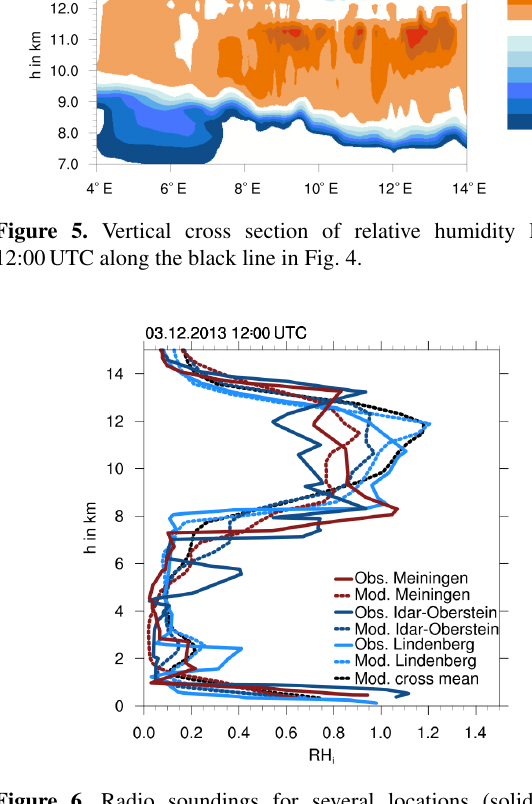
Figure 6. Radio soundings for several locations (solid lines) (UWYO, 2018) and corresponding profiles from aviation simula- tion (dotted lines) of relative humidity RH i . The black dotted line are mean values along the black line in Fig.